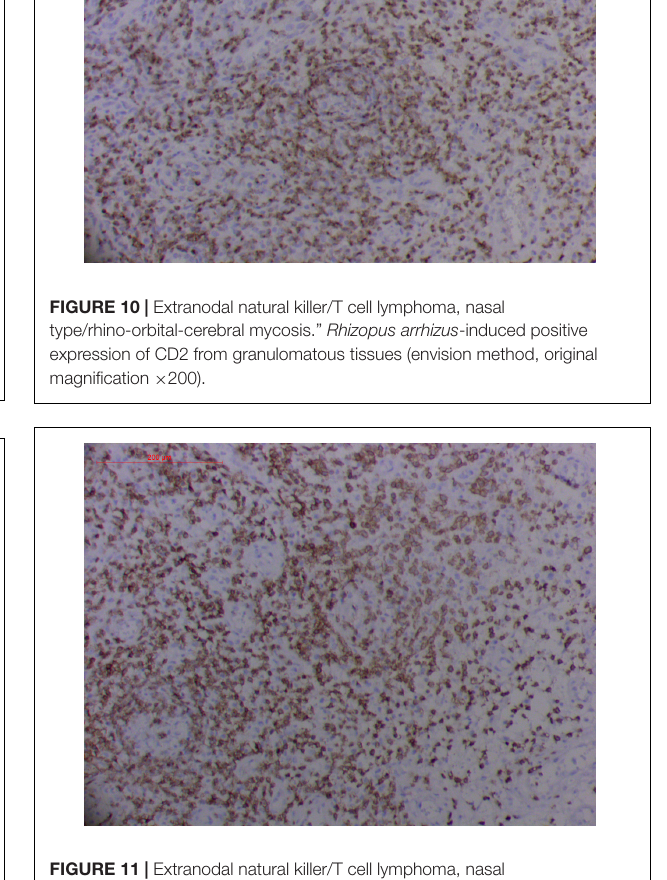
FIGURE 9 | “Extranodal natural killer/T cell lymphoma, nasal type/rhino-orbital-cerebral mycosis.” Rhizopus arrhizus- induced positive expression of KI67 from granulomatous tissues (envision method, original magnification × 200).